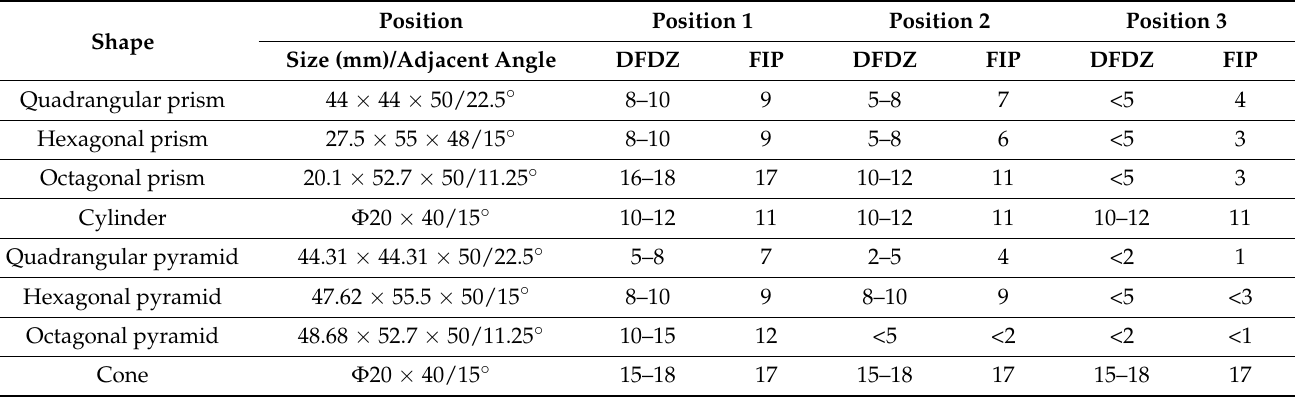
Table 4. The DFDZ and FIP for iron probed objects in the first three